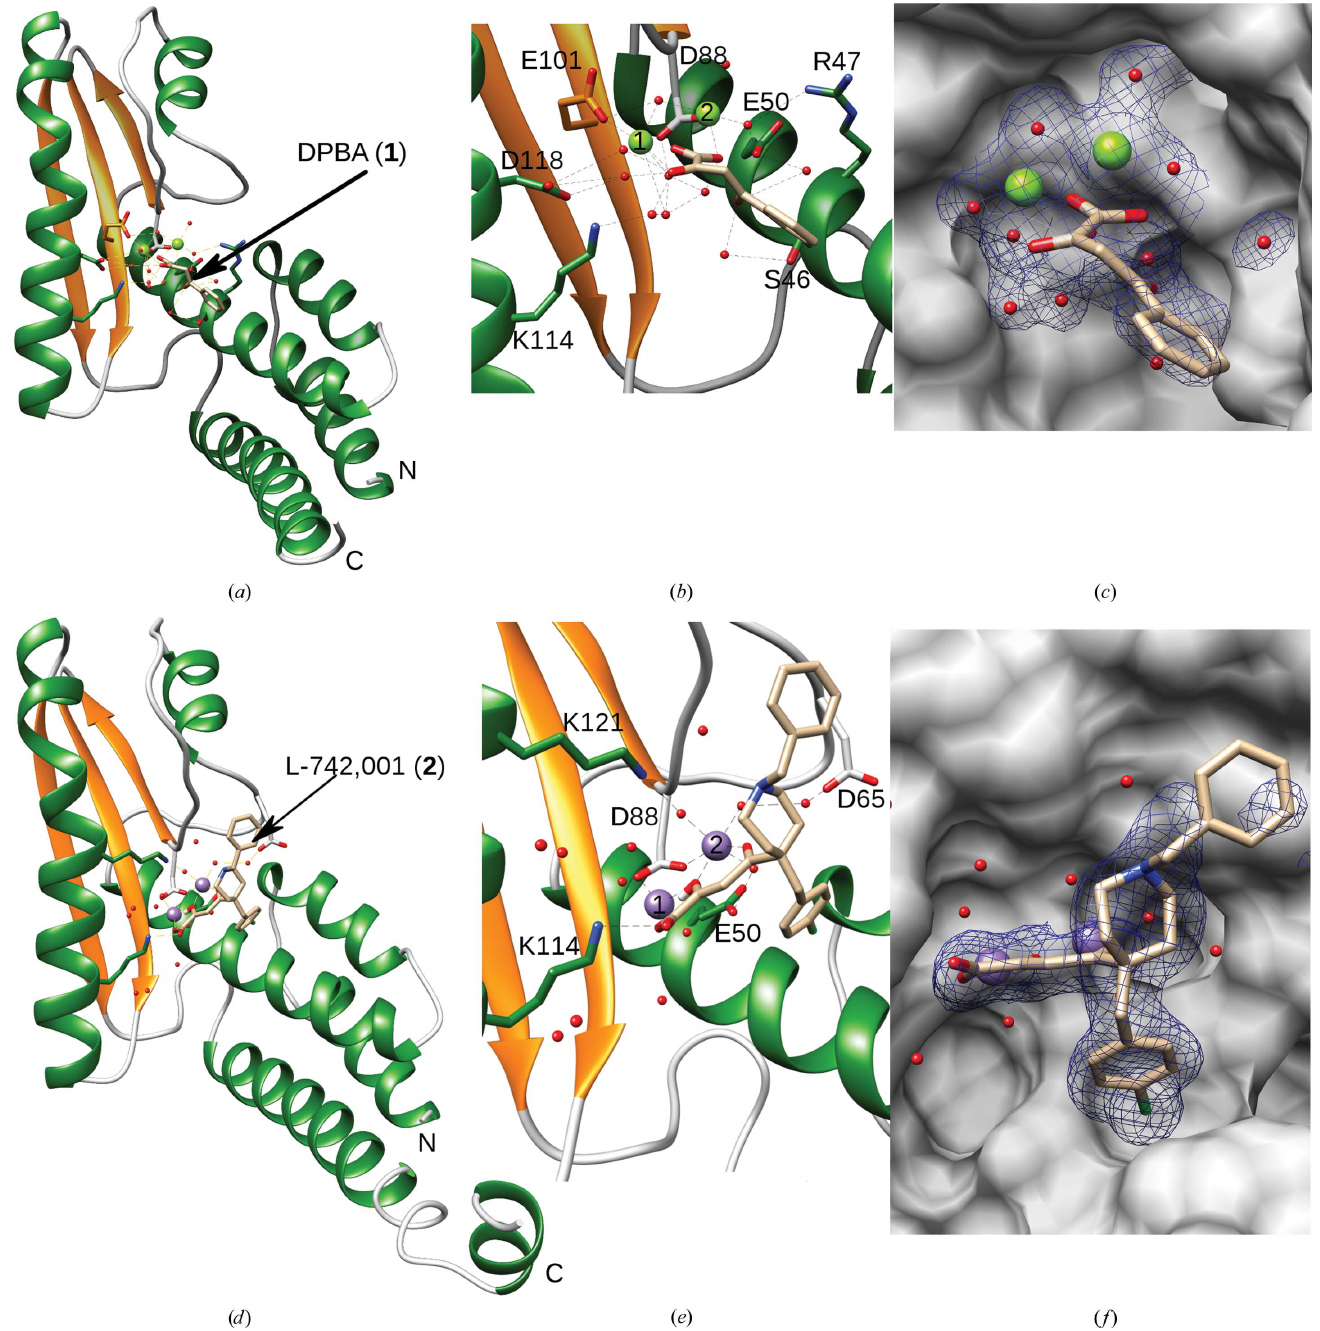
Figure 3 Crystal structures of the ENDO protein in complex with DPBA ( 1 ) and L-742,001 ( 2 ). LCMVendonuclease structures complexed with ( 1 ) ( a , b , c ) or ( 2 ) ( d , e , f ) are shown. Structures are represented as ribbons with helices in green and strands in gold, while the compound is represented as sticks. Mg 2+ and Mn 2+ ions are represented as light green and purple spheres, respectively. ( b ) and ( e ) show enlargements of the catalytic site showing the strong coordination of waters, ions and catalytic residues of the molecule. ( c ) and ( f ) show a 2 F o (cid:5) F c OMIT map corresponding to the compound (1 (cid:5)